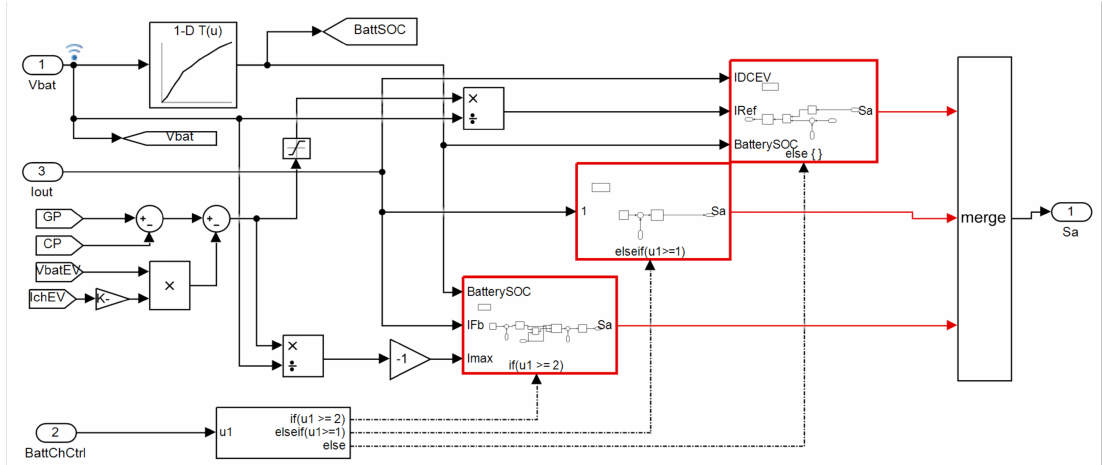
Figure 9. Control Algorithm for battery bank.